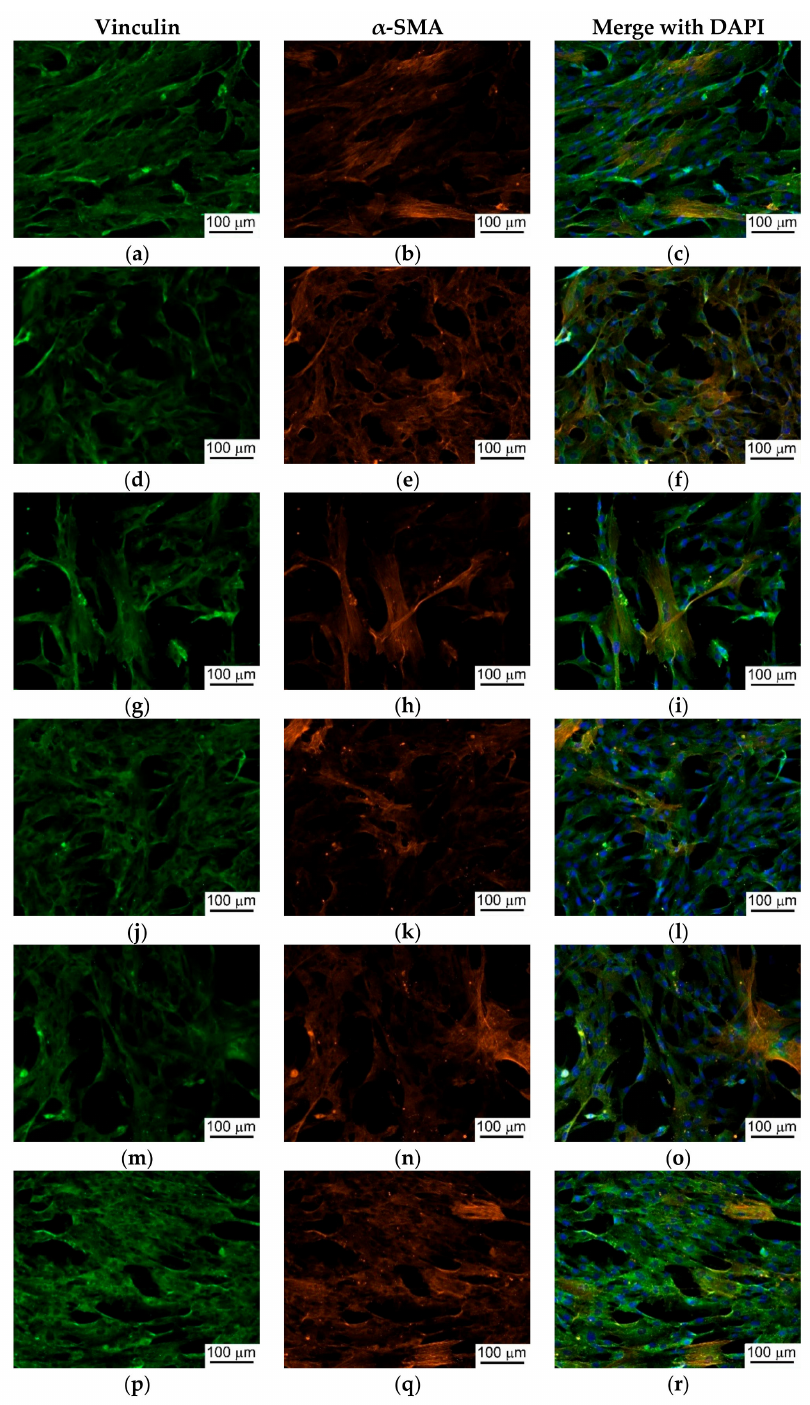
Figure 3. Immunofluorescence staining of MSCs cultured on ZrO 2 substrates with different Ca-P coatings: ( a – c ) ZrO 2 ; ( d – f ) CPT; ( g – i ) HA; ( j – l ) calcium phosphate monobasic; ( m – o ) DCPD; ( p – r ) CPP. Scale bar: 100 µ